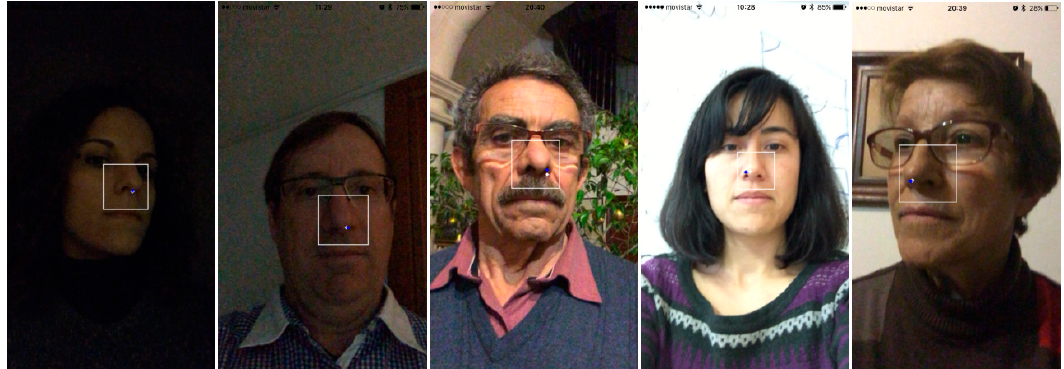
Figure 5. The system’s functioning with different users, lightings and backgrounds.